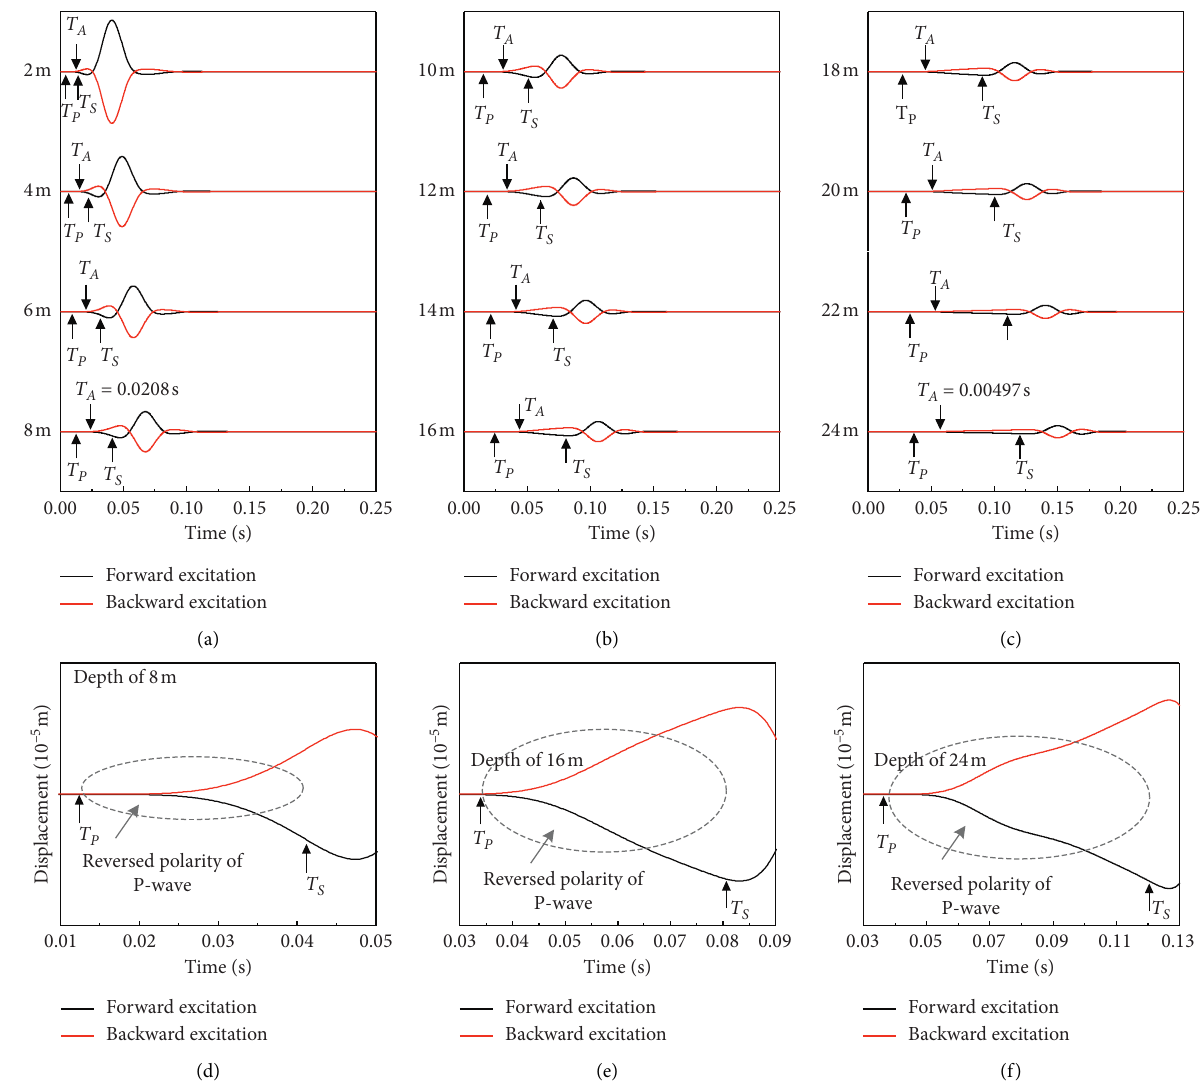
Figure 2: Signal traces at different depth observation points in the horizontal X direction under the forward and backward excitation; (a)–(c) the original signal traces at different selected depth; (d)–(f) amplified waveform of partially signals at 8m, 16m, and 24m ob- servation